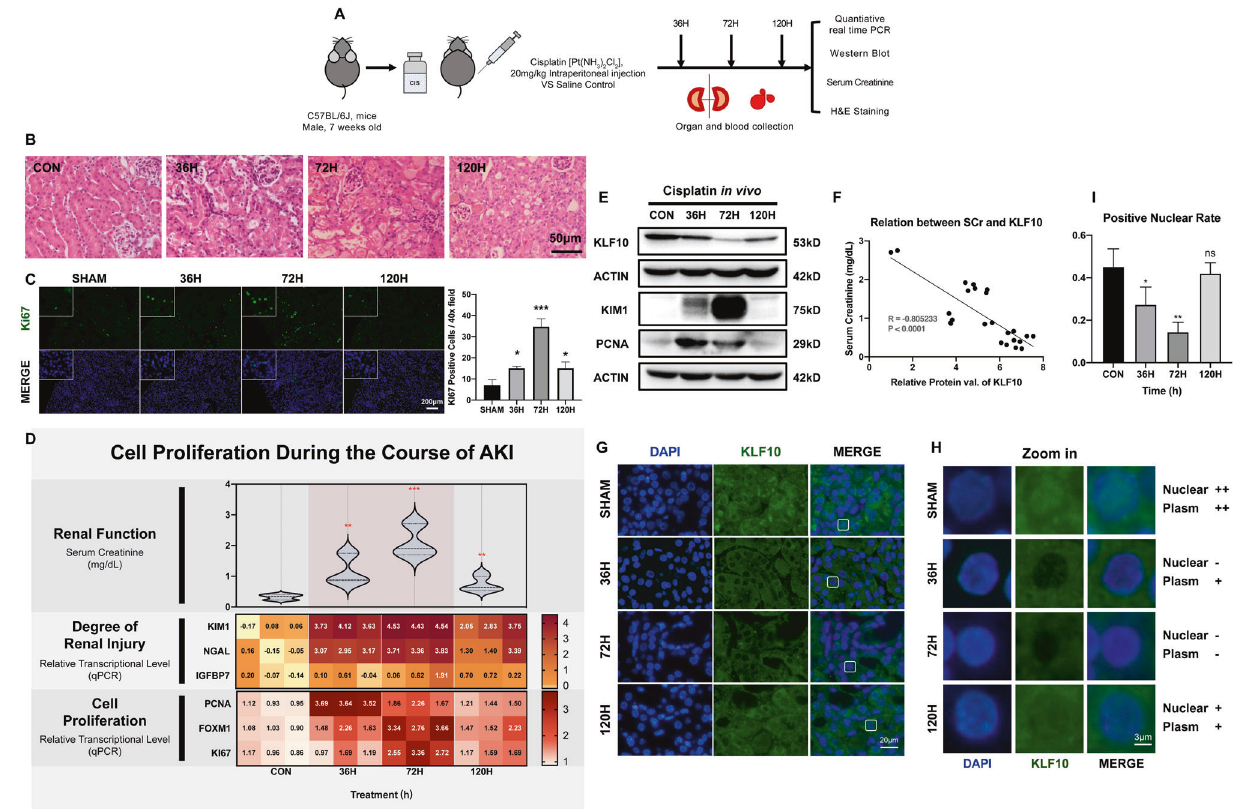
Fig. 3 Downregulation of KLF10 was correlated with cell proliferation and the outcome of cisplatin-induced AKI in vivo. A Flowchart detailing cisplatin treatment regime in C57BL/6 J mice. n = 6 per group. B Representative H&E staining image of kidney sections from the model. C Representative immuno fl uorescence staining image of Ki67 in the model and counts of positive cells per 40x fi eld (objective lens). D Renal dysfunction was determined in cisplatin (20 mg/kg, ip) treated mouse model. Serum creatinine (SCr) was measured in sera. Degree of renal injury was determined in the model through relative mRNA levels of KIM1, NGAL and IGFBP7 in mouse kidney tissues. Degree of renal cellular proliferation was determined in the model through relative mRNA levels of PCNA, FOXM1 and Ki67 in mice kidney tissues. E Representative immunoblot analysis of KLF10, KIM1 and PCNA in the model. ACTIN served as the standard. F Regression analysis was undertaken to determine correlation between relative protein level of KLF10 in mice kidney tissues and SCr. Relative protein level of KLF10 was examined and normalized by Fiji. G – I Representative immuno fl uorescence staining image and rate of positive nuclear of KLF10 in the model. * p < 0.05, ** p < 0.01, *** p < 0.001, ns no signi fi cantly difference vs control group at the same experimental